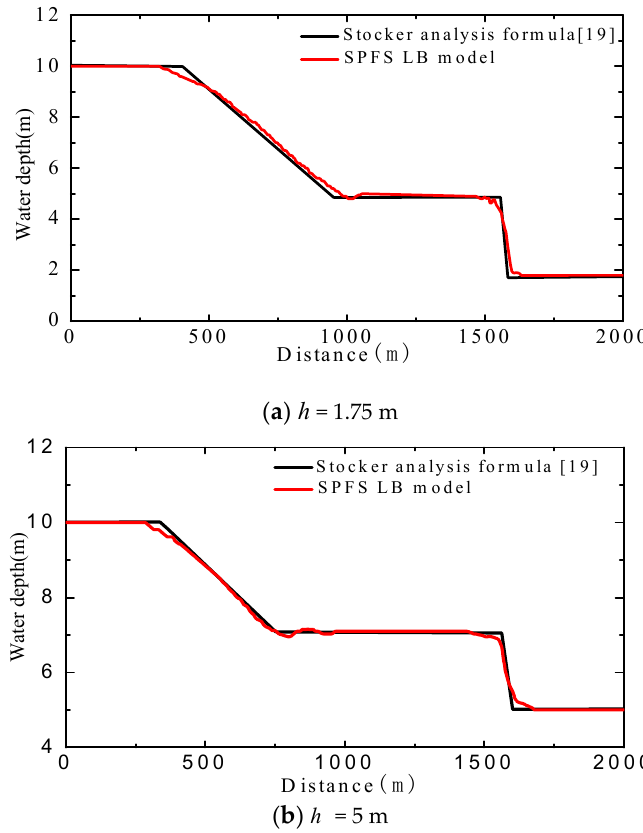
Figure 2. Water surface profile of a 1-D dam-break wave (60 s after dam failure), ( a ) h = 1.75 m, ( b ) h = 5 m.